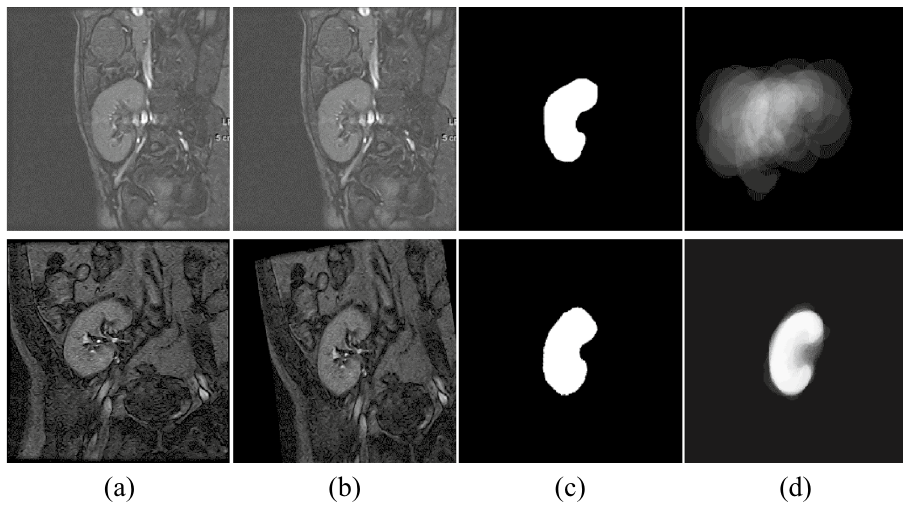
Figure 2. Kidney shape model construction from DCE-MRI images: ( a ) Sample images, ( b ) Images after affine transformation, ( c ) Segmented kidneys after alignment, ( d ) The shape prior model constructed using the Bayesian parameter estimation method before (top) and after (bottom) the affine